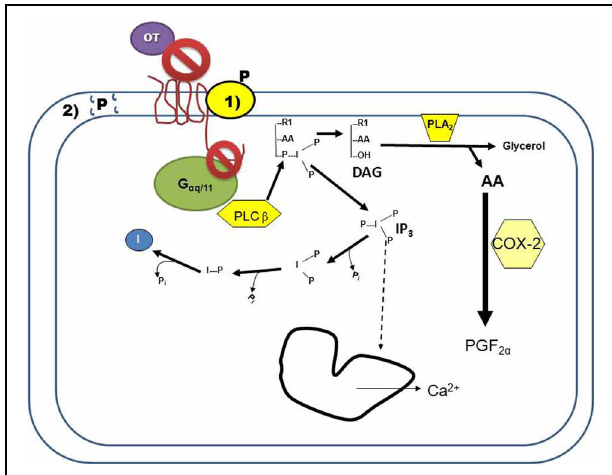
FIGURE 1 | Progesterone (P) inhibition of oxytocin receptor (OXTR) signaling in endometrial cells. Binding of oxytocin (OT) to the OXTR activates the G-protein, G α q / 11 . The activated G-protein phosphorylates the enzyme phospholipase C β (PLC β ), which cleaves phosphatidylinositol 4,5-bisphosphate into DAG and inositol 1,4,5-trisphosphate (IP 3 ). Released IP 3 induces intracellular calcium release (Ca 2 + ) from the endoplasmic reticulum, and is then recycled into free inositol. Free arachadonic acid (AA) is cleaved from DAG by phospholipase A2 (PLA2) and then converted by cyclooxygenase 2 (COX2) into prostaglandin F 2 α (PGF 2 α ). Blockage of this signaling cascade by P can occur by two mechanisms: (1) P binding to a membrane-associated binding protein that interacts with the OXTR, resulting in conformational changes to the receptor such that OT is not able to bind and/or the OXTR is unable to interact with the G-protein. (2) P overloading of the plasma membrane results in changes to membrane fluidity, preventing the OXTR from interacting with the G-protein. Both of these mechanisms of action would result in P-mediated decreased signaling of the